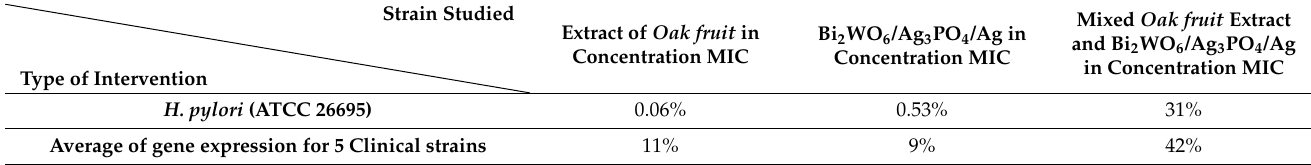
Table 5. The percentage of expression of urease A gene in MIC concentration in H. pylori strains was studied in the presence of Extract of Oak fruit , Nano-structure of the Bi 2 WO 6 /Ag 3 PO 4 /Ag mixed Bi 2 WO 6 /Ag 3 PO 4 /Ag.